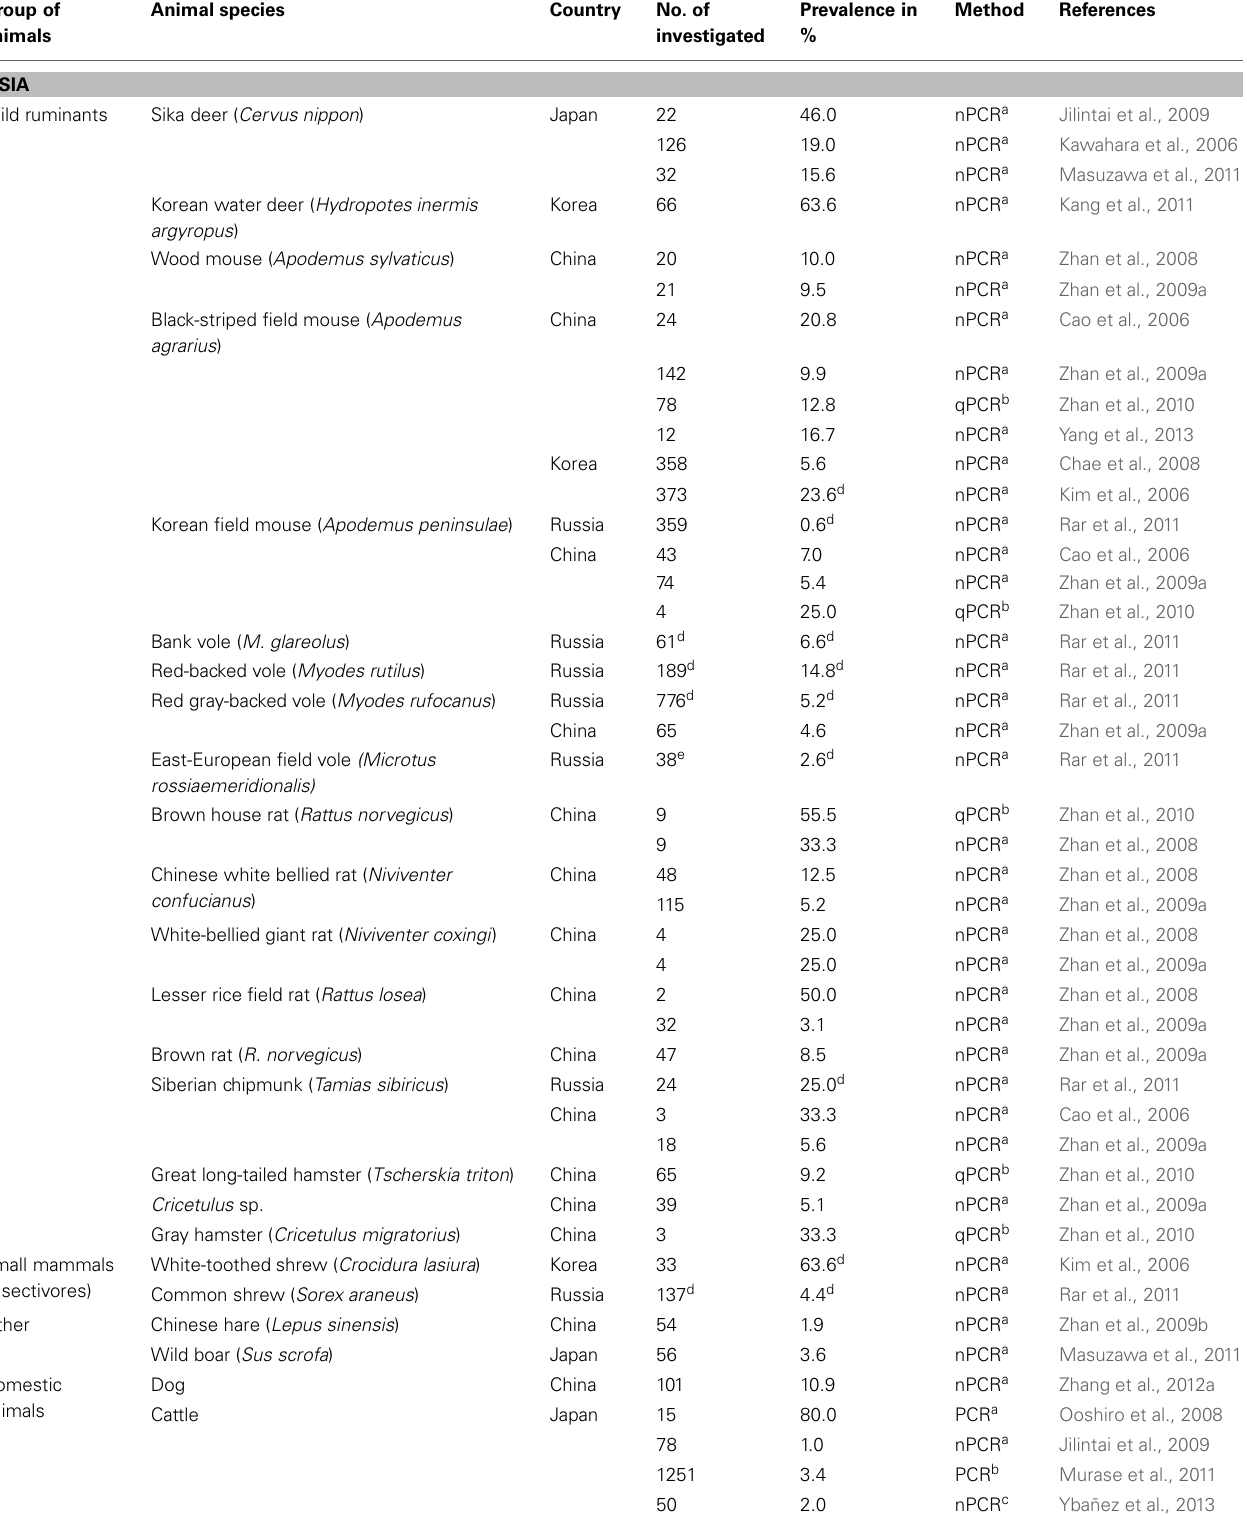
Table 8 | Detection of DNA of Anaplasma phagocytophilum in spleen/blood of vertebrate hosts in Asia and Africa*. Group of Animal animals